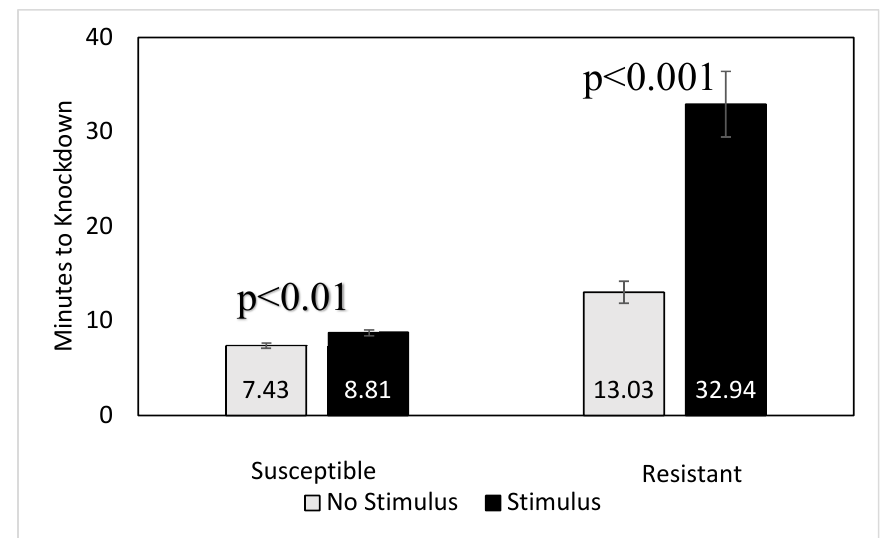
Figure 3. Mean (SE) time to knockdown of individual Tribolium castaneum from susceptible and resistant populations exposed to approximately 3000 ppm of phosphine while stimulated or not stimulated during the observation time. p -values are those for t -test analyses for comparison of knockdown times for physically disturbed and undisturbed beetles.